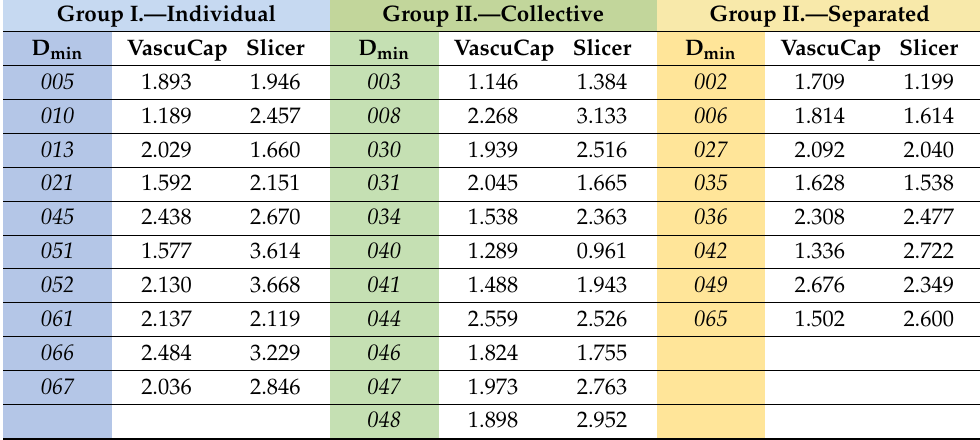
Table A1. Minimum diameter D min values (in mm dimension) obtained from both segmentation methods for all